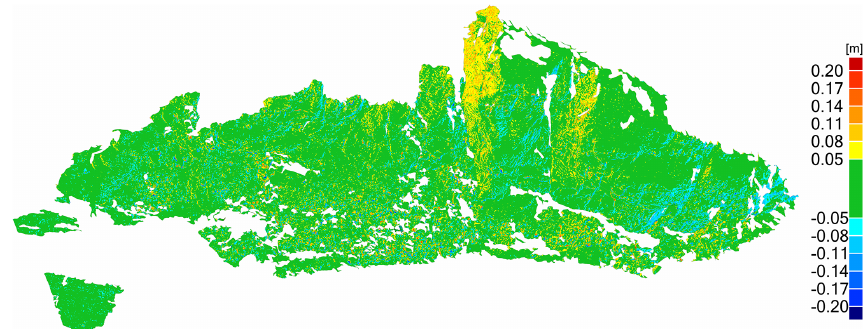
Figure 13. Comparison between the reference dataset and results generated based on the ICProx